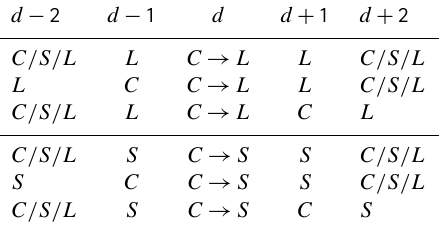
Table 1. Intervention rules for step 2. Cloud pixels to be reclassified are those at day d . The table displays only those combinations of observations between d − 2 and d + 2 that admit the intervention of step 2. In all the other possible cases this conservative filter is skipped. d −